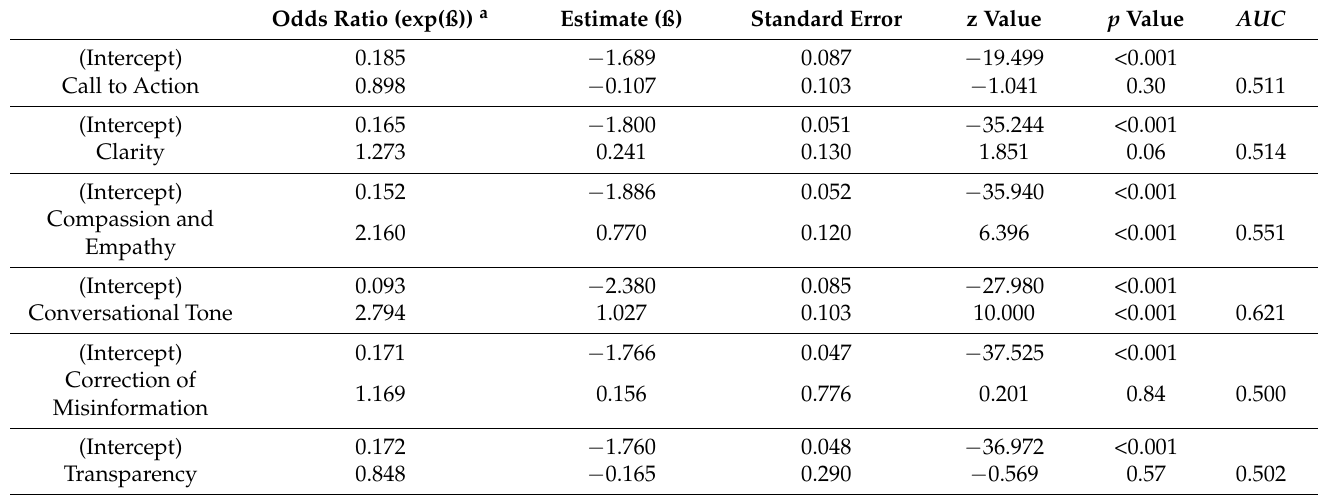
Table 4. Results from six univariate logistic regression analyses each with a different guiding principle as the predictor variable for the level of tweet engagement.